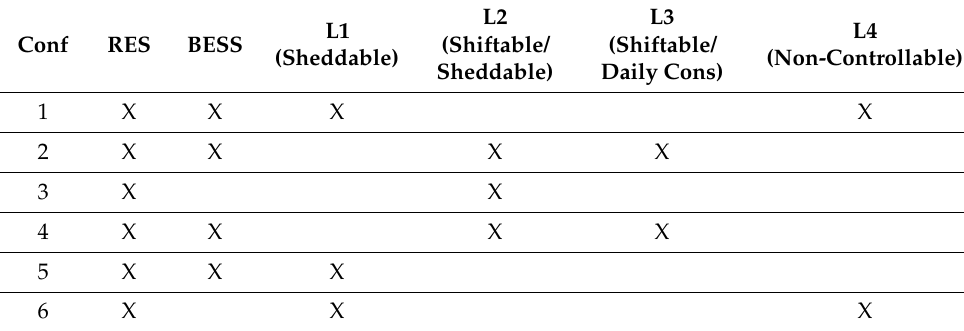
Table 2. Mixed configurations and components based on scenario 5.